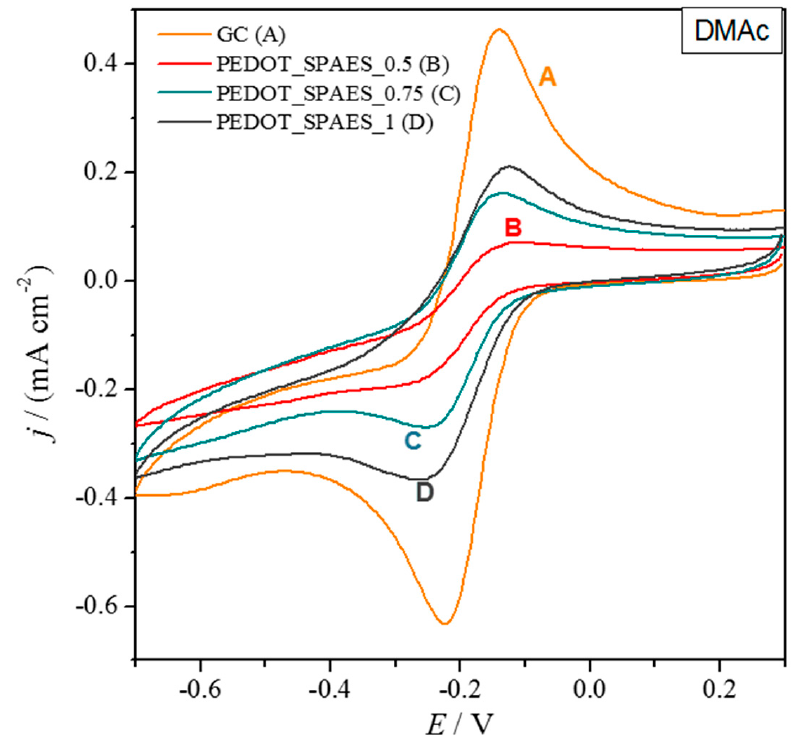
Figure 8. Cyclic voltammograms of bare glassy carbon (GC) and modified GC with polymers